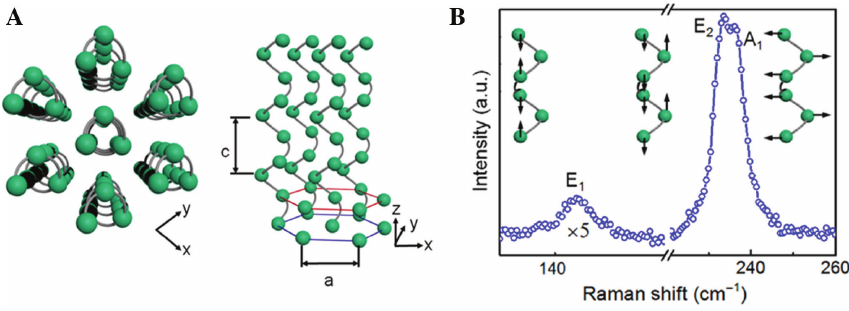
Figure 5: Structure and physics of 2D Se. (A) Atomic structures of selenium. (B) Raman spectral of selenium nanosheets. Reproduced with permission from Ref. [163]. Copyright 2017, American Chemical